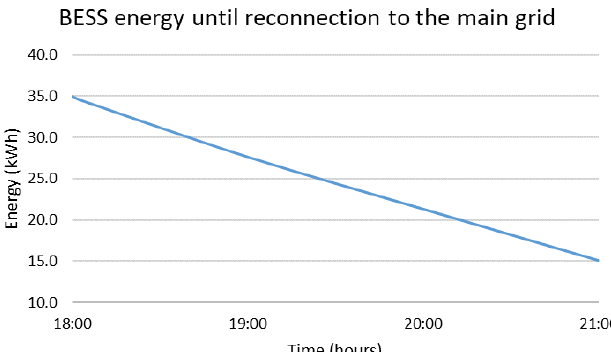
Figure 10. Energy stored in BESS 1 for a black start at 18:00. Figure 10 . Energy stored in BESS 1 for a black start at 18:00.